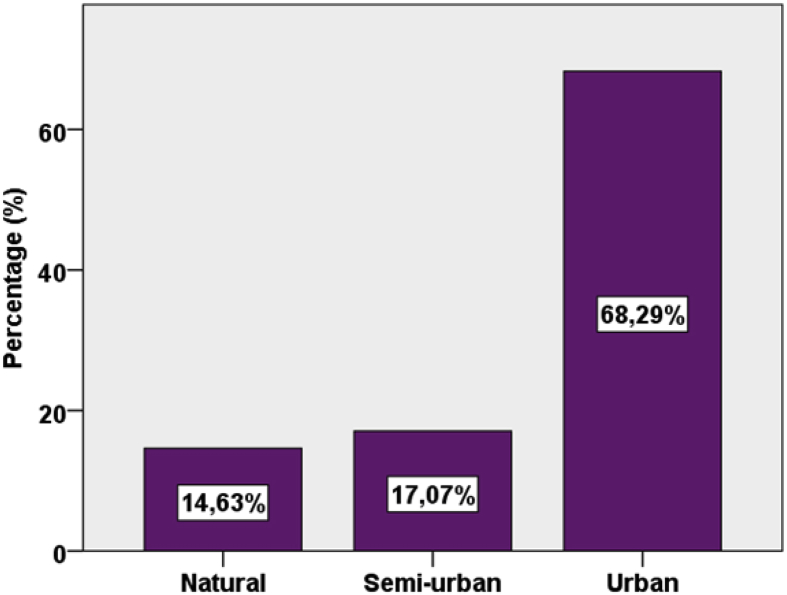
Selected beaches classified by Ref. [1].